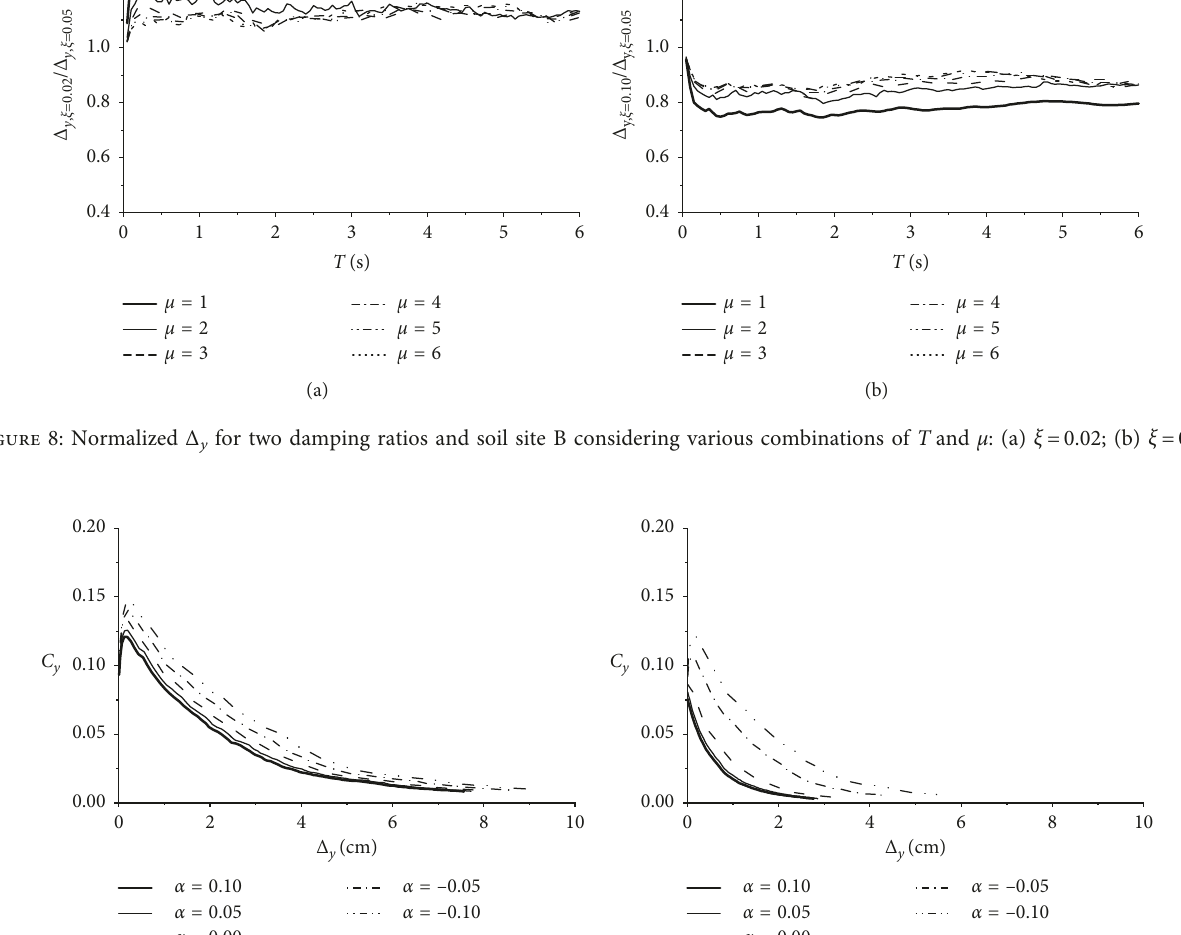
Figure 9: Effects of postyield stiffness on YPS for soil site B considering two ductility factors: (a) μ � 2; (b) μ � 5.